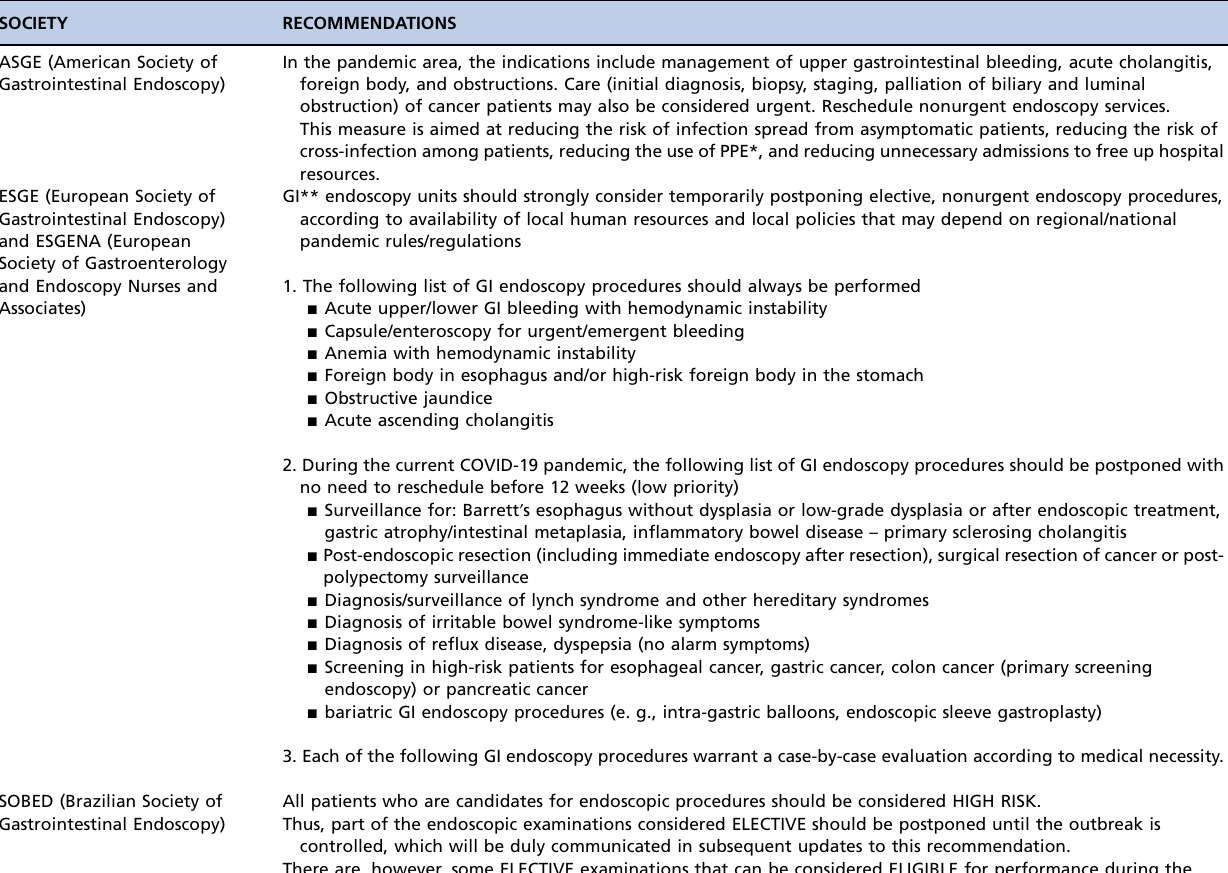
Table 1 - Society vs .